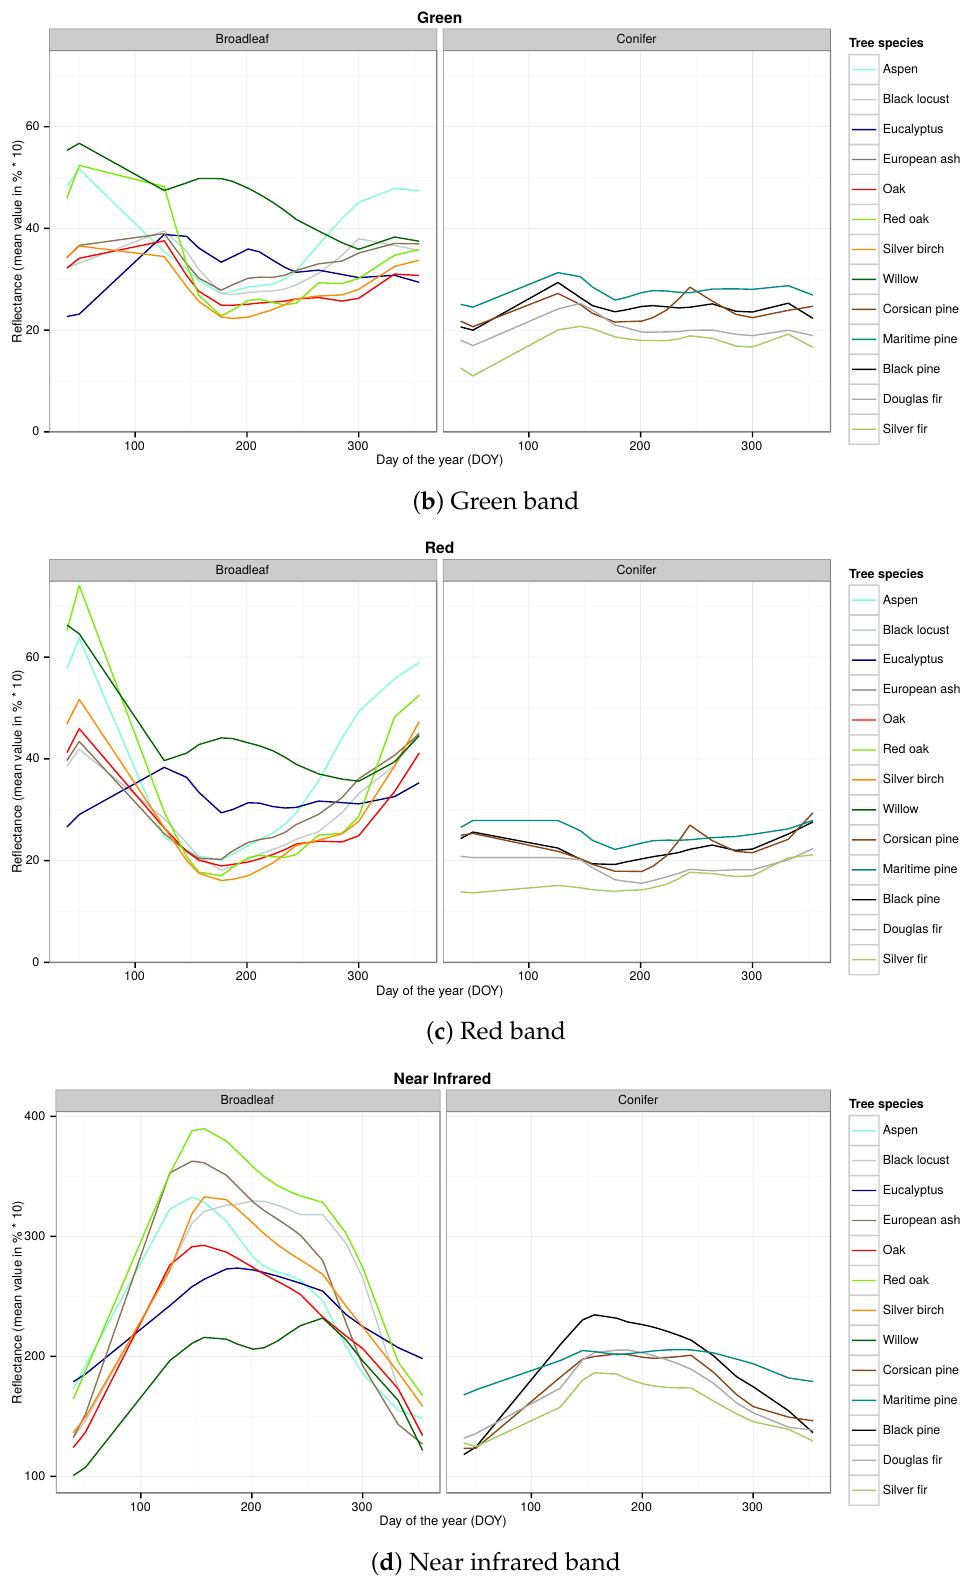
Figure B1. Average spectral signatures of the thirteen tree species in the blue ( a ), green ( b ), red ( c ) and near infrared ( d ) spectral bands of the SITS. Reflectance values ( y-axis ) are given for each day of the year ( x-axis ) in percent, multiplied by a factor of